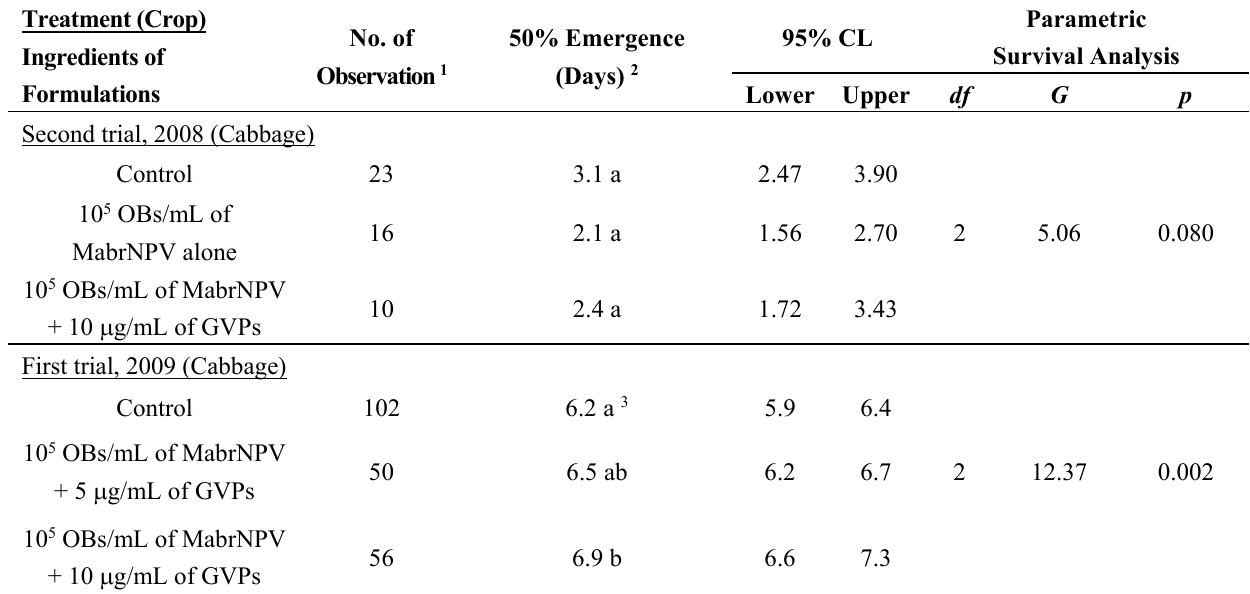
Table 5. Times required for 50% emergence of parasitoid larvae from